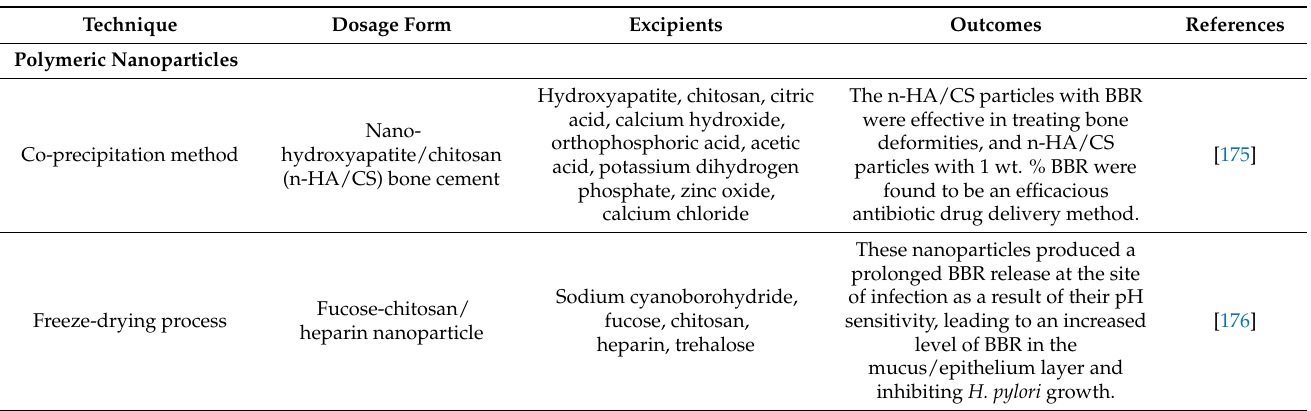
Table 2. Summary of numerous nanoformulations, their dosage form, excipients, and outcomes in drug delivery of berberine